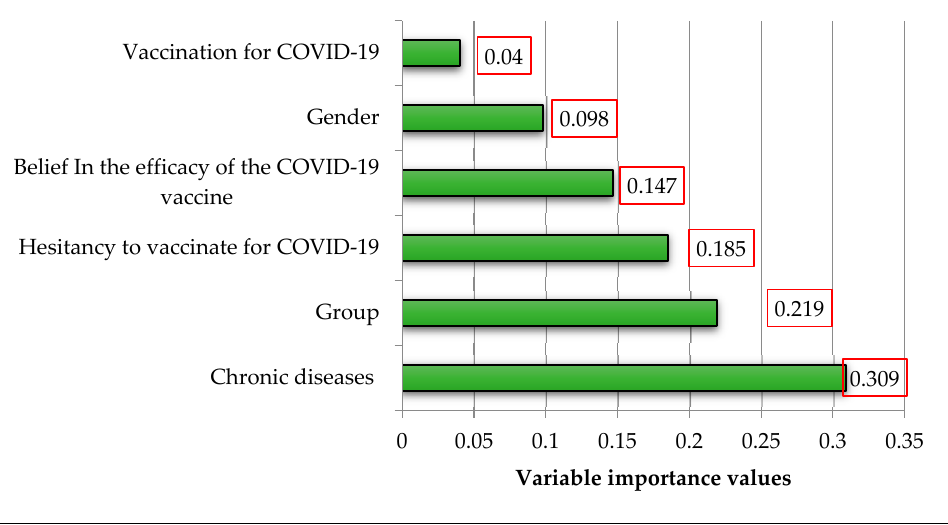
Figure 2. The graph of variable importance values for CAS-SF score .